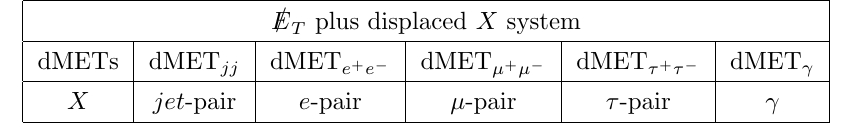
Table 4 . Minimal set of dMETs searches for neutral displaced SM particles. To facilitate the trigger acceptance for these topologies, especially for soft X systems, the dMETs can be combined with an ISR signature, such as an additional hard jet or hard (cid:13) . A list of basic operators that would give rise to such topologies is shown in table